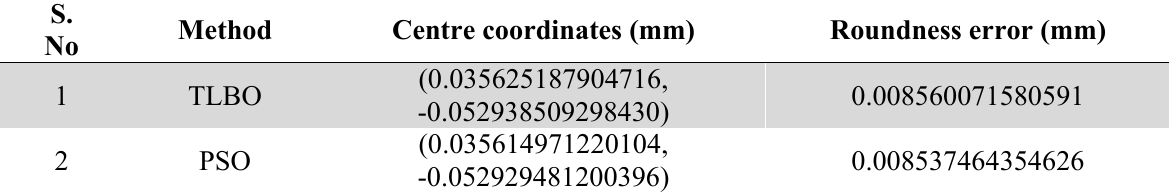
Centre co-ordinates of MZC obtained using TLBO and PSO algorithms S.